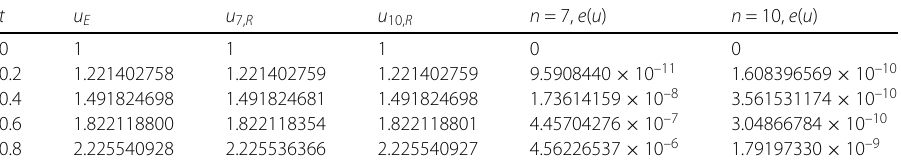
Table 7 Numerical result of Example 5.6